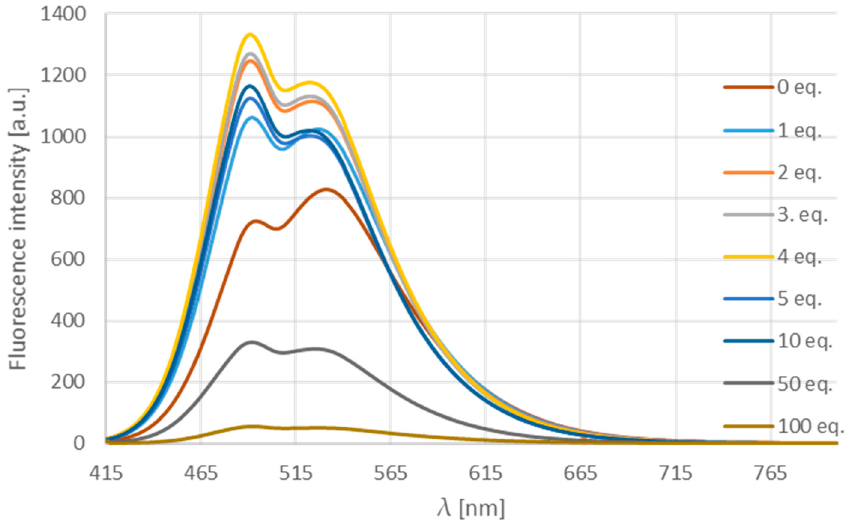
ff erent equivalents Pd 2 dba